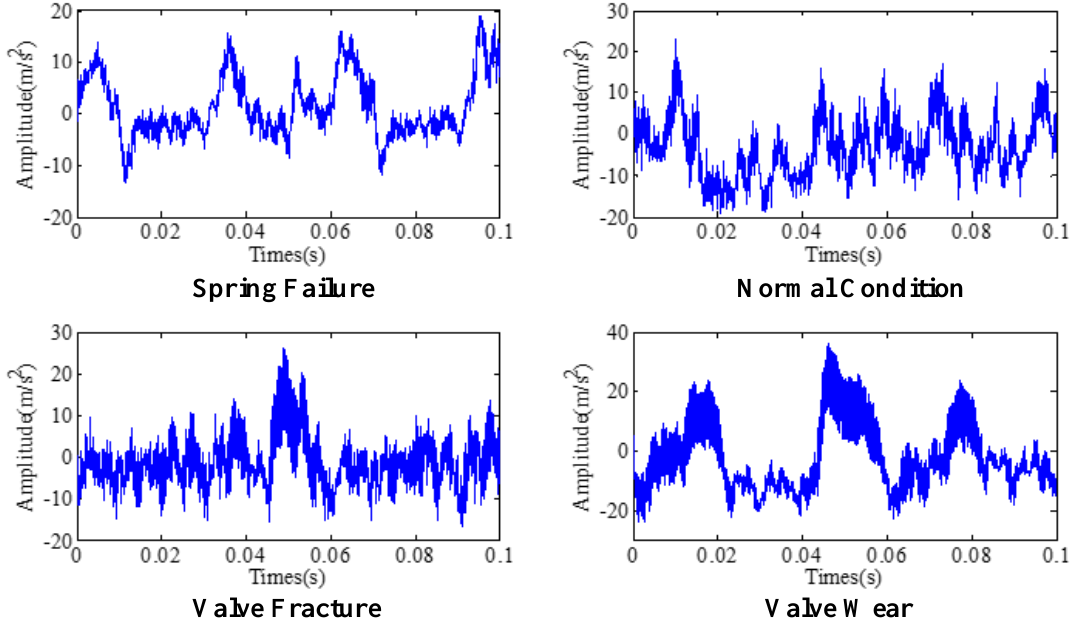
Figure 5. The time-domain waveforms of four datasets